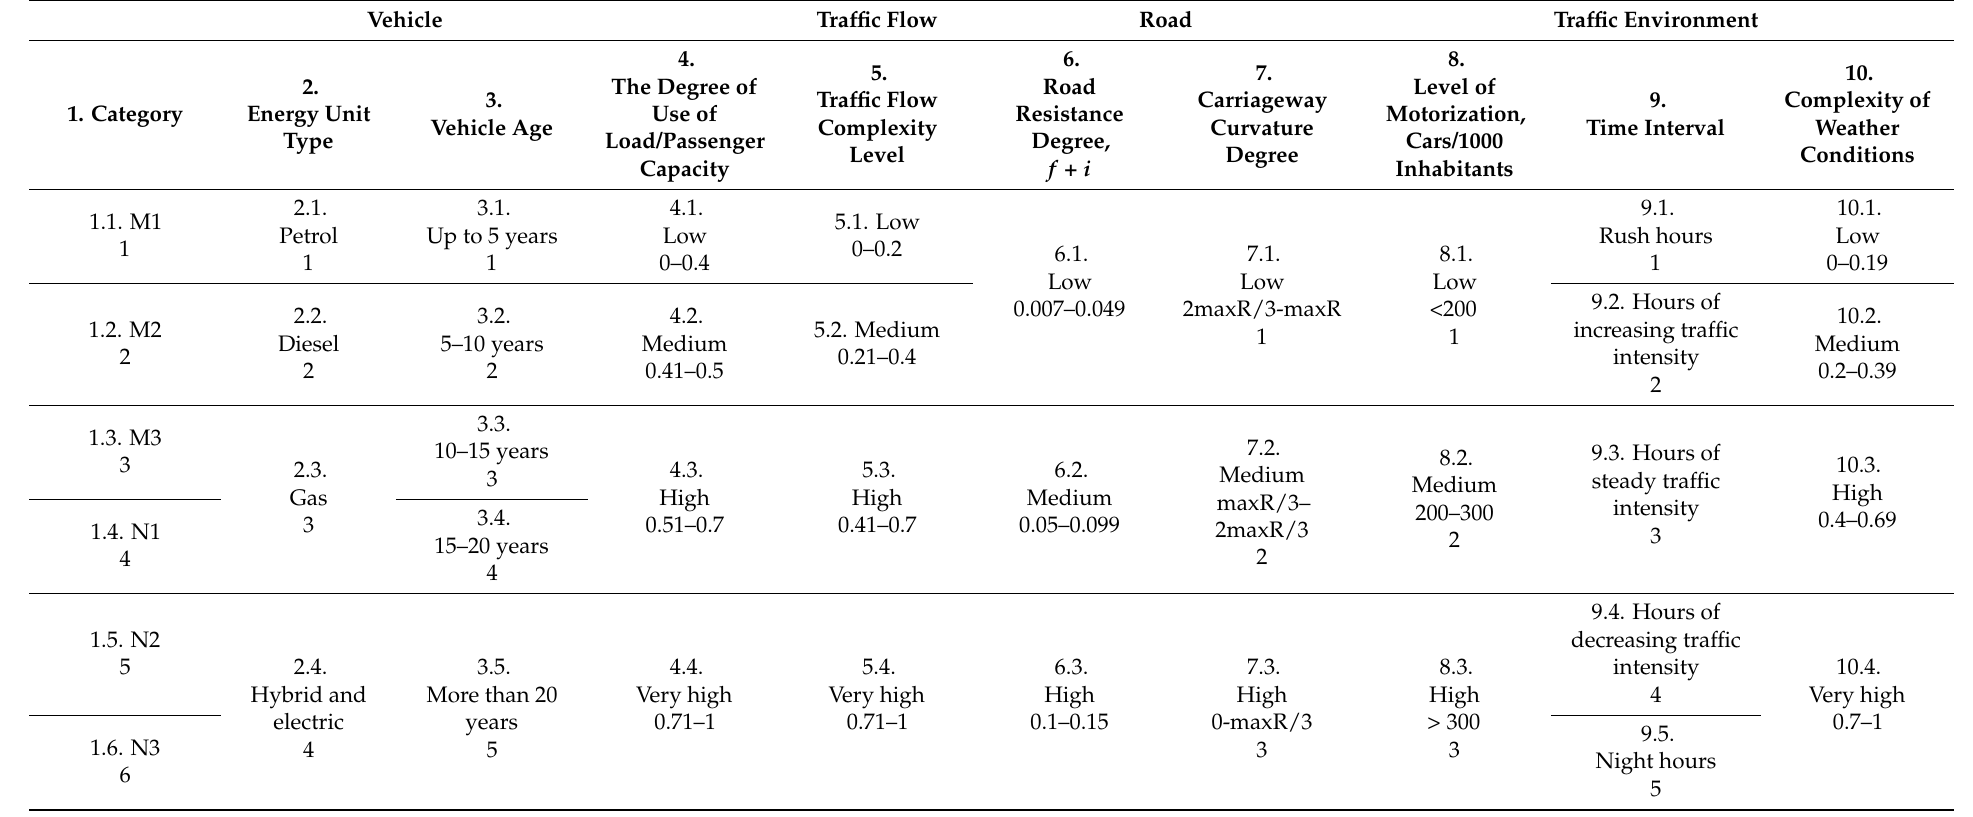
Table 2. Modified morphological matrix of the TrEECS system (built according to the results